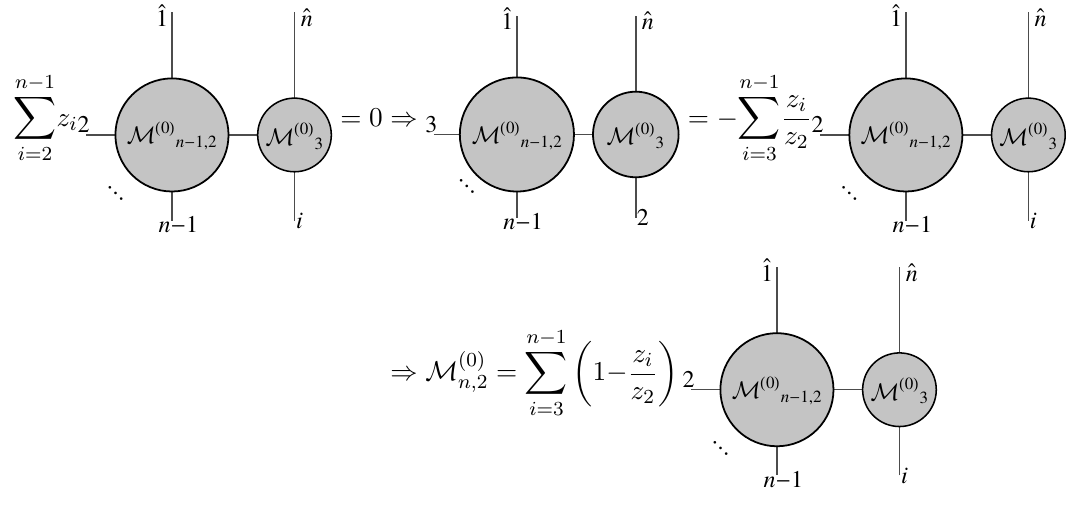
Figure 23 . The MHV bonus relations in N = 8 SUGRA can be used to eliminate one channel from the recursion in (cid:12)gure 22, reducing the number of channels from ( n (cid:0) 2) to ( n (cid:0) 3). For N = 8 SUGRA, the superamplitudes vanish like O